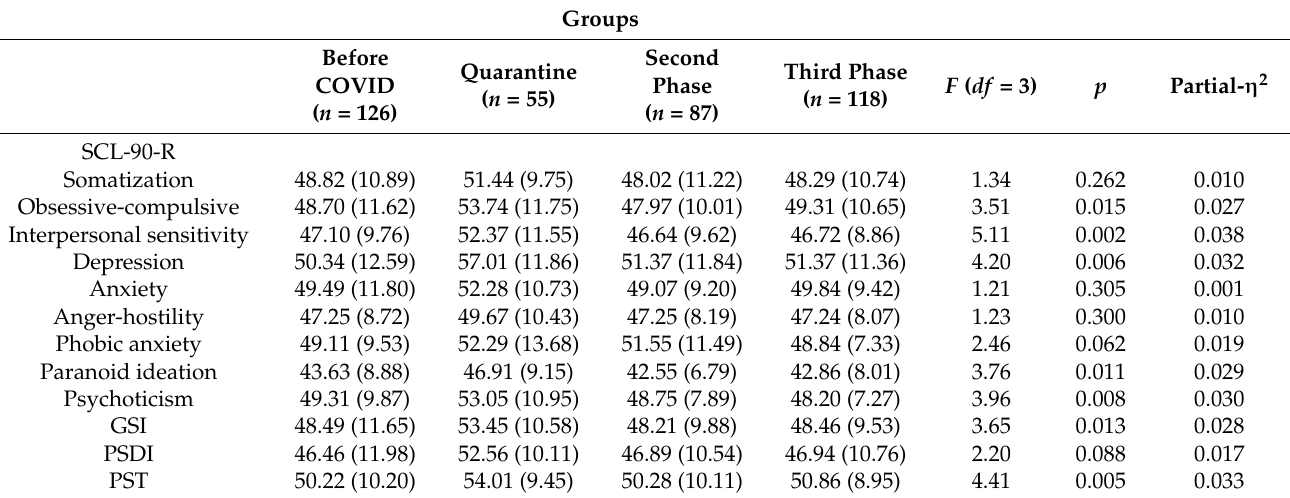
Table 4. Mean ( SD ) score by female groups; ANOVA analysis.